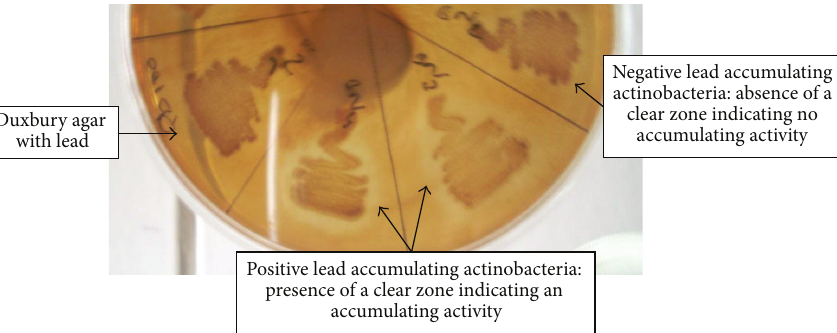
Figure 3: Example of positive and negative lead accumulating actinobacteria on Duxbury agar supplemented with